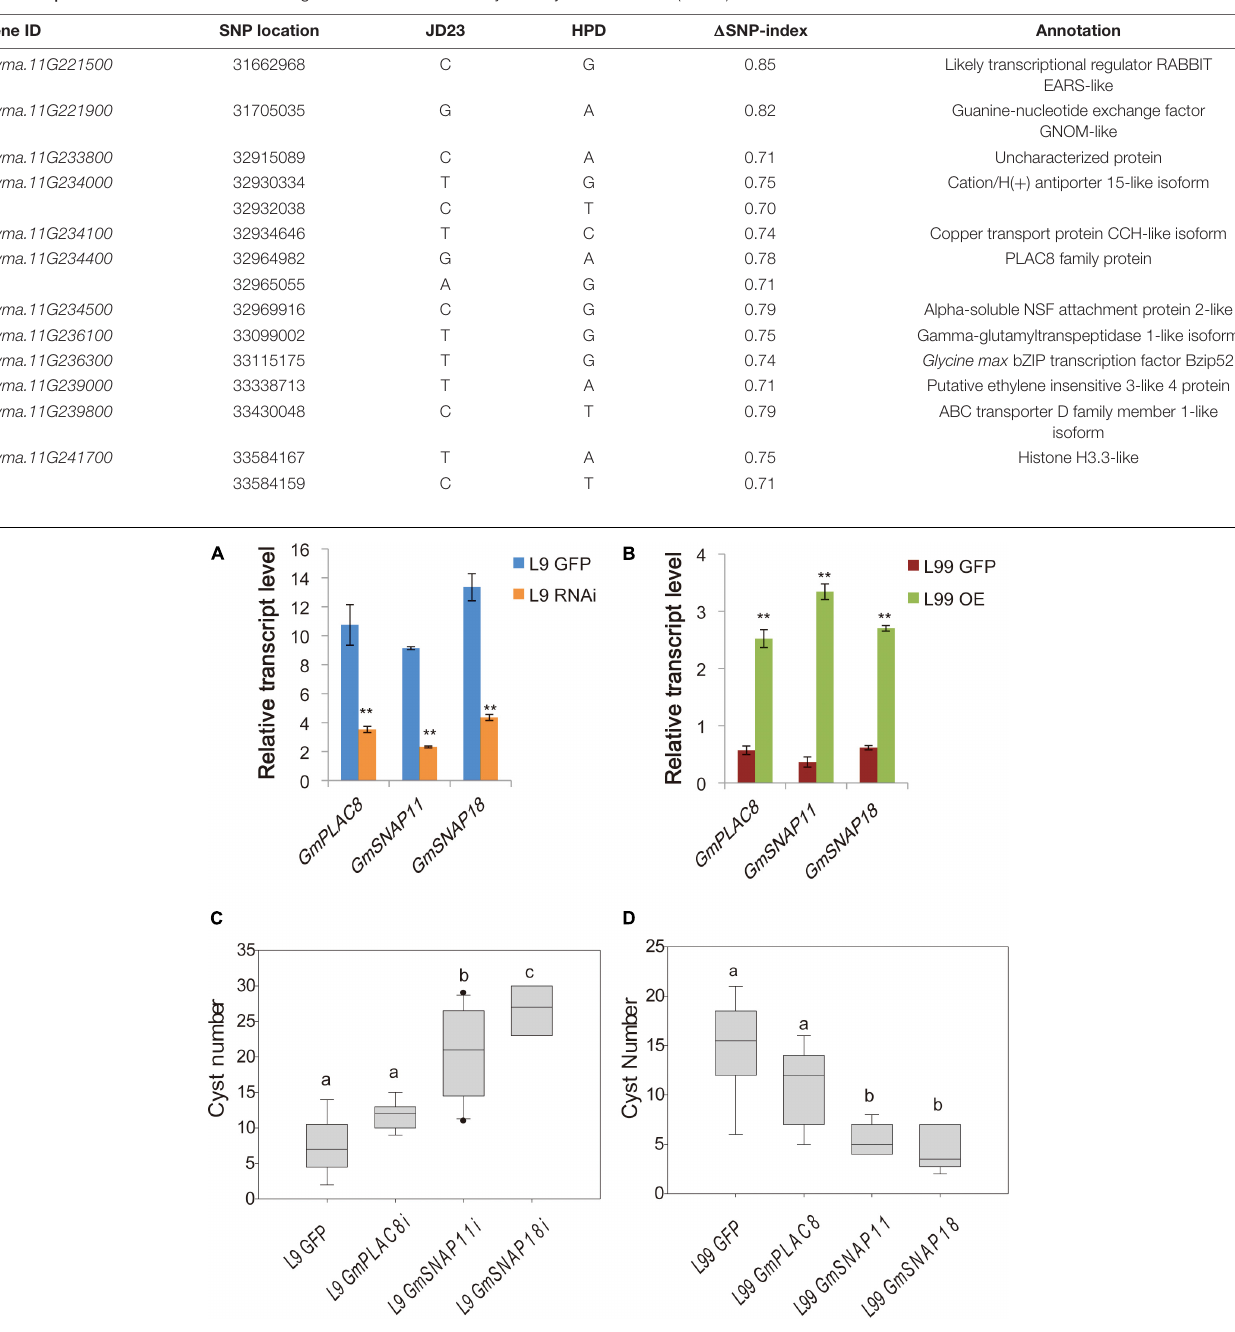
TABLE 1 | Annotation of the 12 candidate genes for resistance to soybean cyst nematode 4 (SCN4). Gene ID